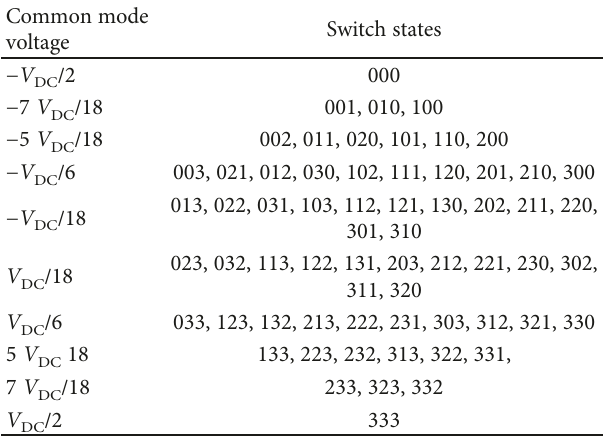
Table 2: Switching states and common mode voltage of four-level NNPC